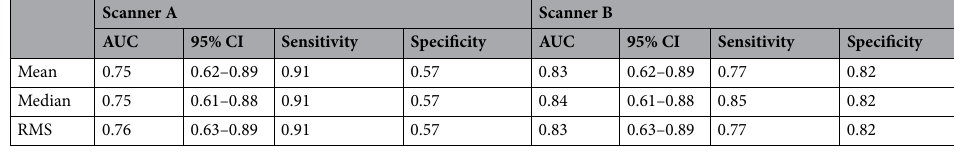
Table 4. Overlapping features differentiating DS4-positive and DS4-negative lymphoma manifestations on both scanners. Summary of the ROC analysis for scanner A and B. Only features with p < 0.05 in the Mann- Whitney-U-test and diagnostic performance > 0.70 on both scanners are shown. Only median remains after applying different feature reduction methods. Complete results are given in the supplementary Tables S3 and S4. RMS root mean squared, AUC area under the curve, 95% CI 95% confidence